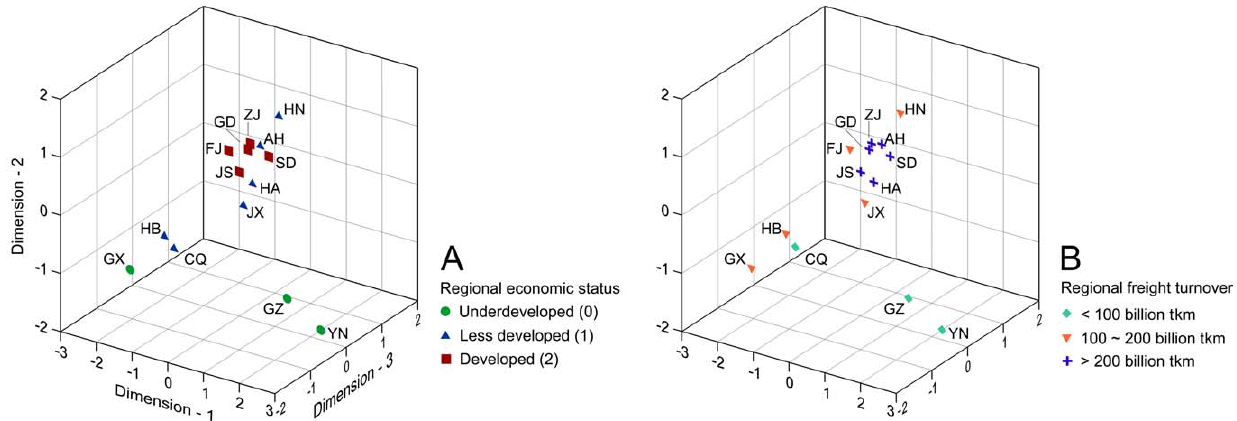
Figure 2. 3D Multidimensional scaling (MDS) plots based on Kimura two-parameter (K2P) distances of 14 M.alternatus populations in China categorized by regional economic status (A) and regional freight turnover (B). The two-letter population codes in the plots correspond to the provincial codes listed in Table 1.